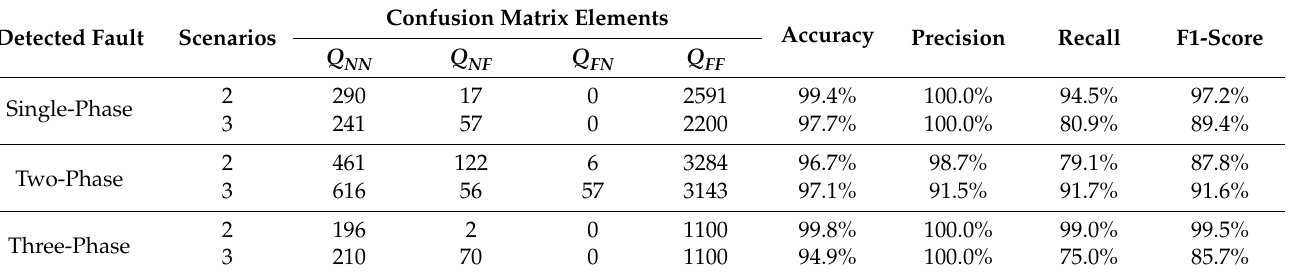
Table 9. Confusion matrix metrics to evaluate the detection stage for scenarios 2 and 3.